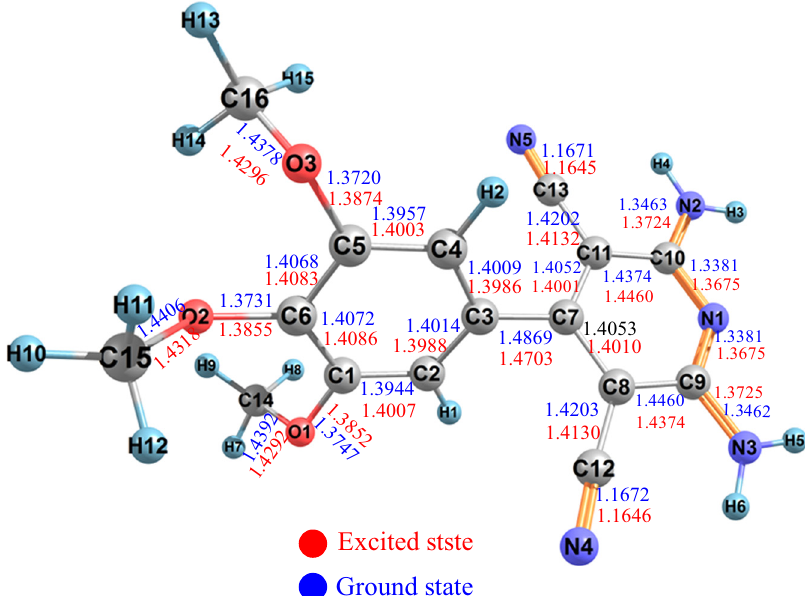
Figure 6: Optimized geometry of DTPP in acetonitrile solvent in the ground and excited states.